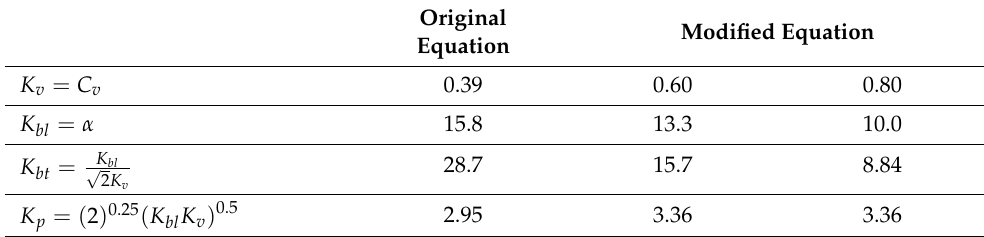
Table 1. Coefficients of spray tip penetration